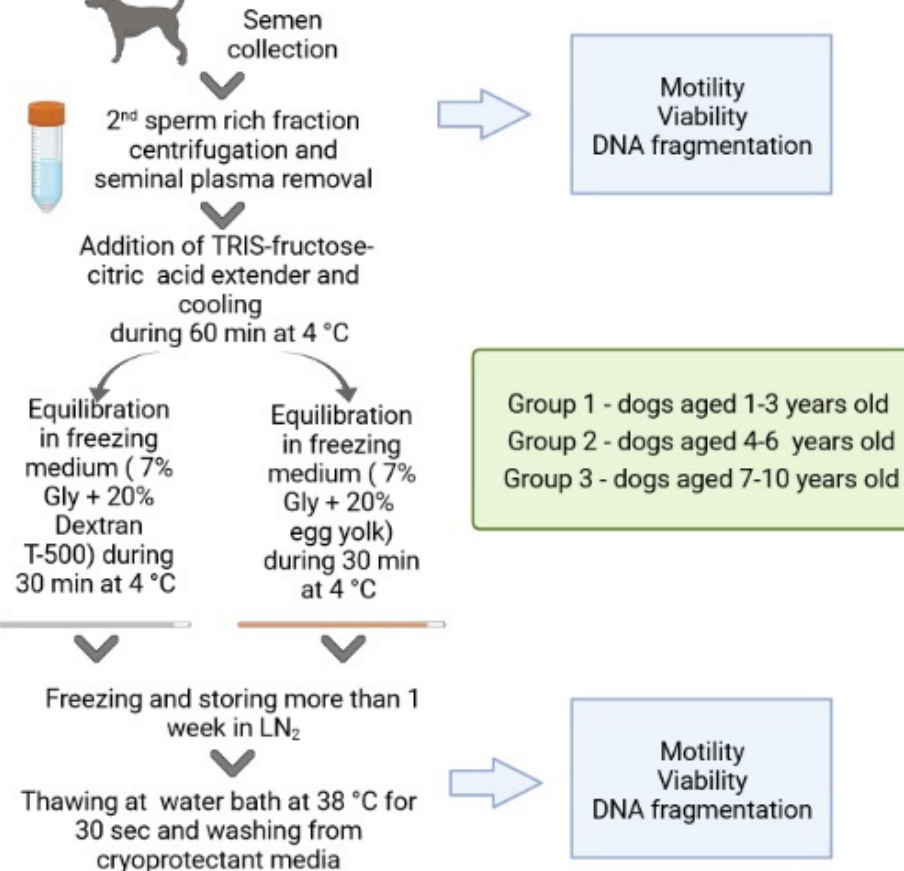
Figure 1. Experimental design for semen collection, data processing, and analysis.